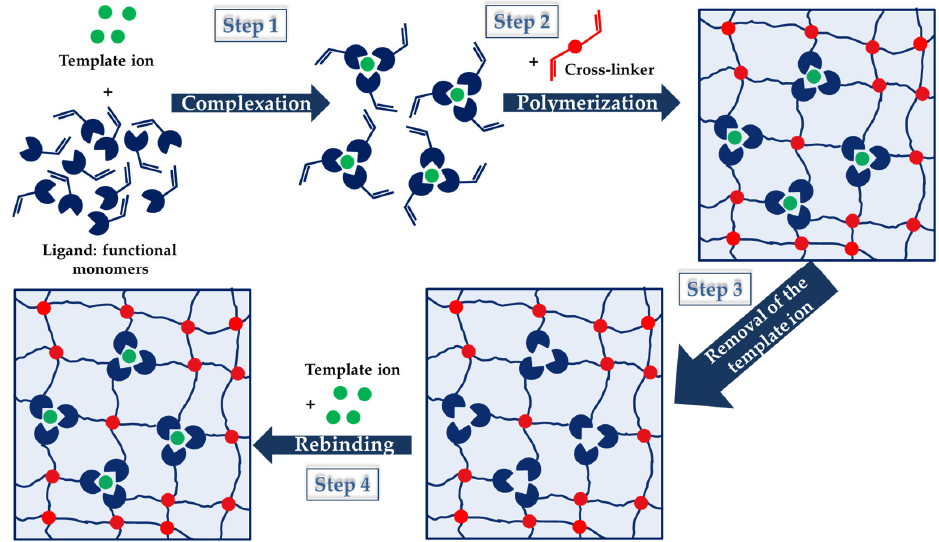
Figure 2. A schematic representation of the steps employed within the IIPs synthesis. The imprinting process is presented using functional monomers as ligand.